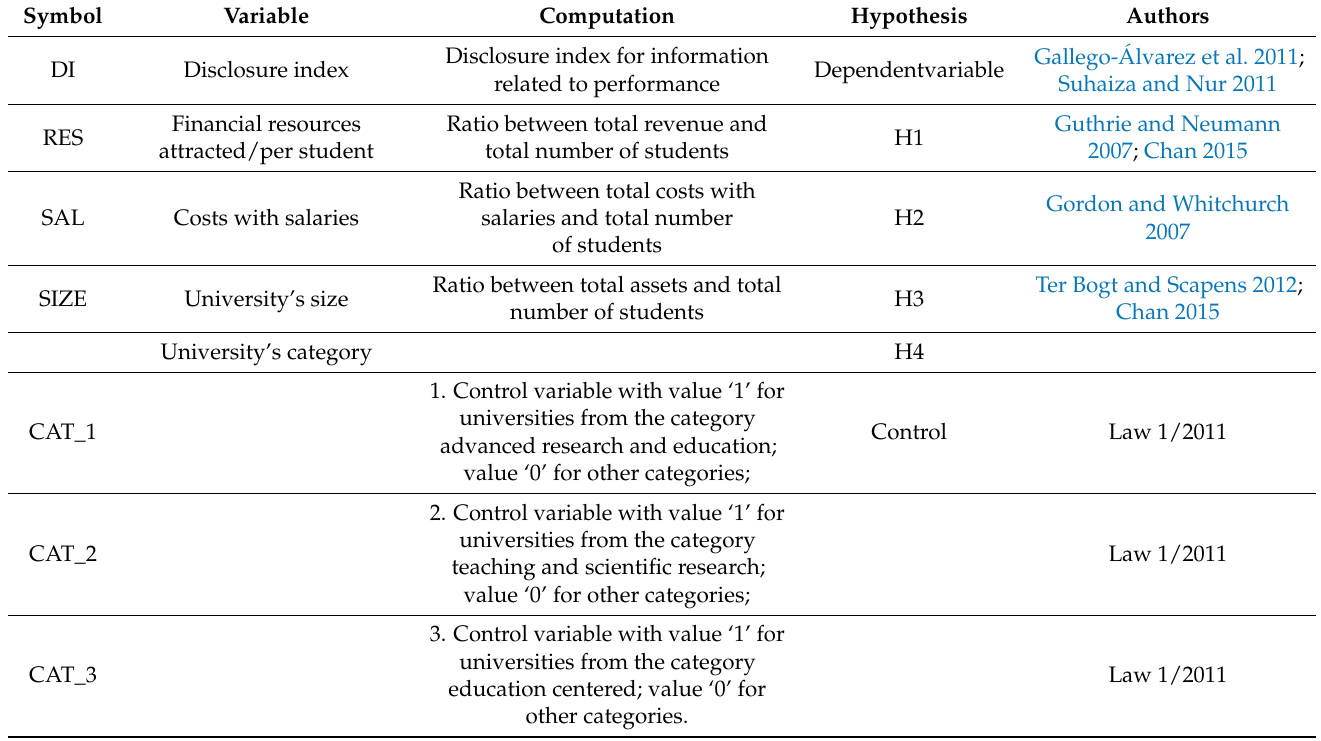
Table 1. Description of the variables used in the statistical